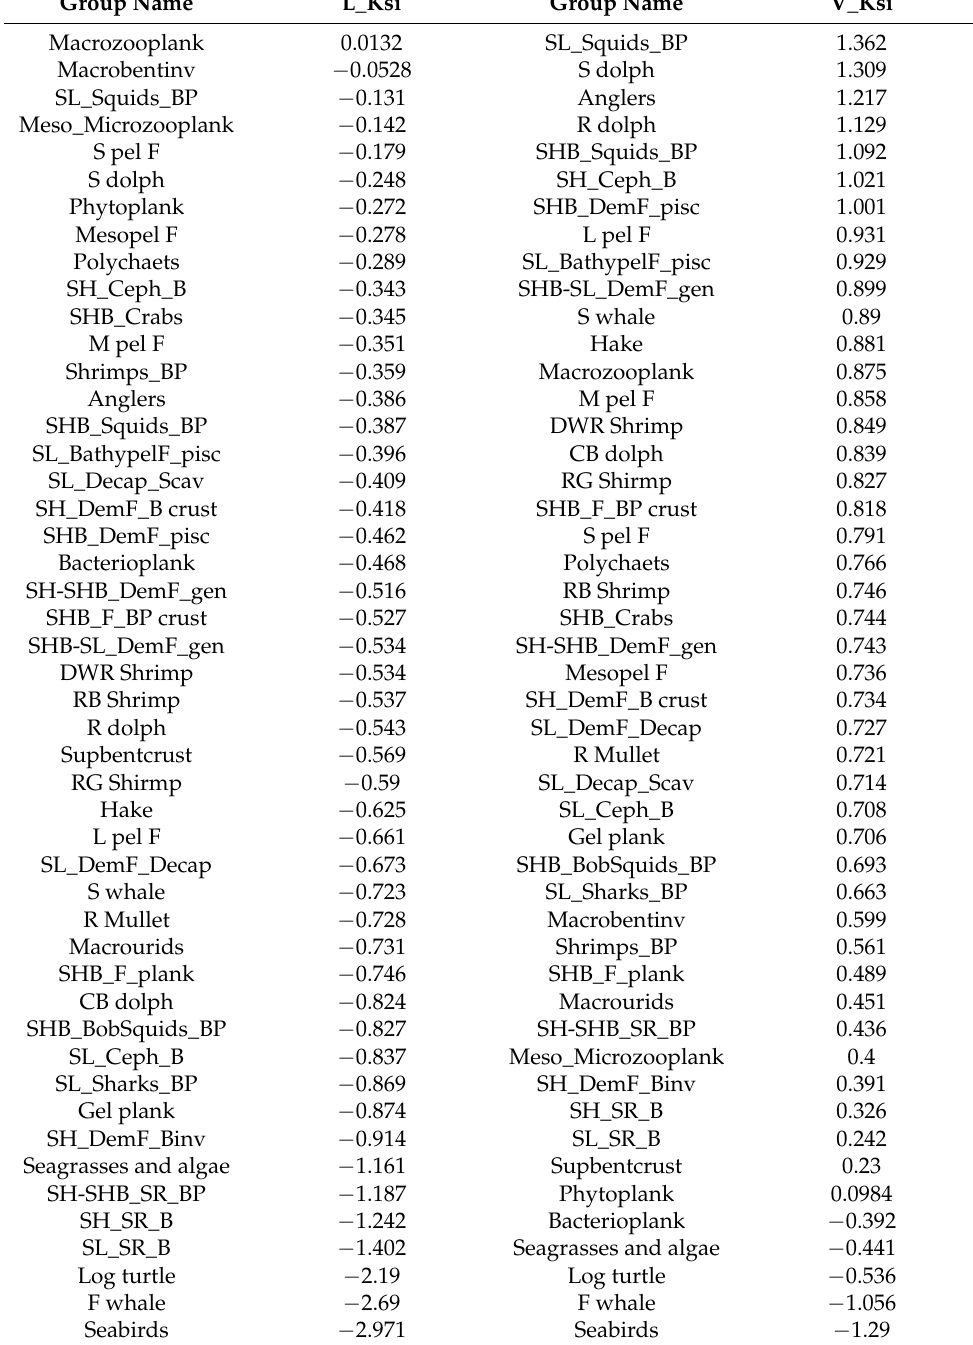
Table A2. The functional groups in the food web model ranked in descending order according to their keystoness, by means of Libralato [91] (L_Ksi) and Valls [92] (V_Ksi)